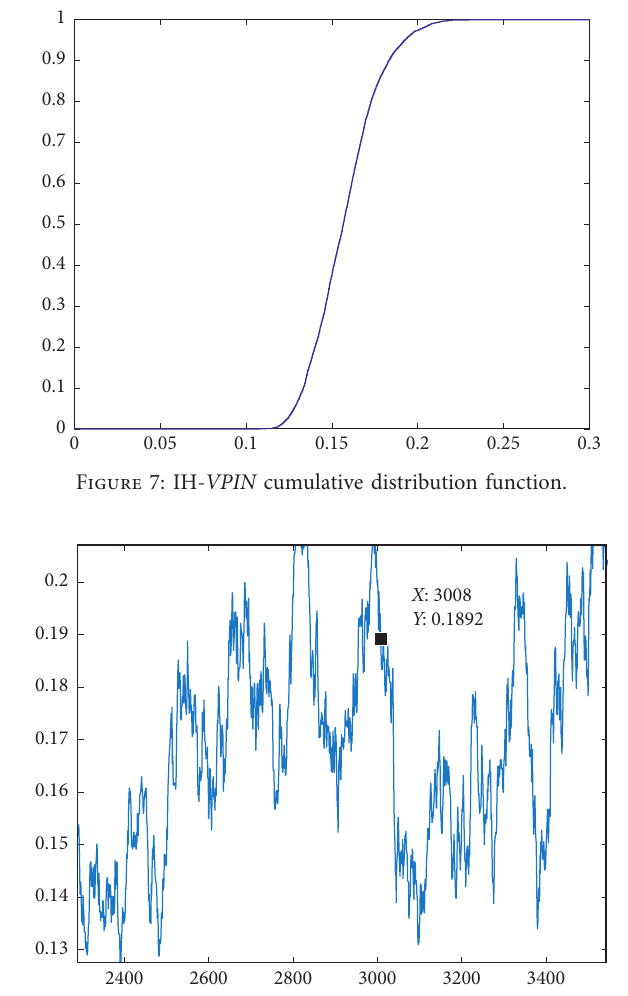
Figure 8: IH -VPIN sequence.